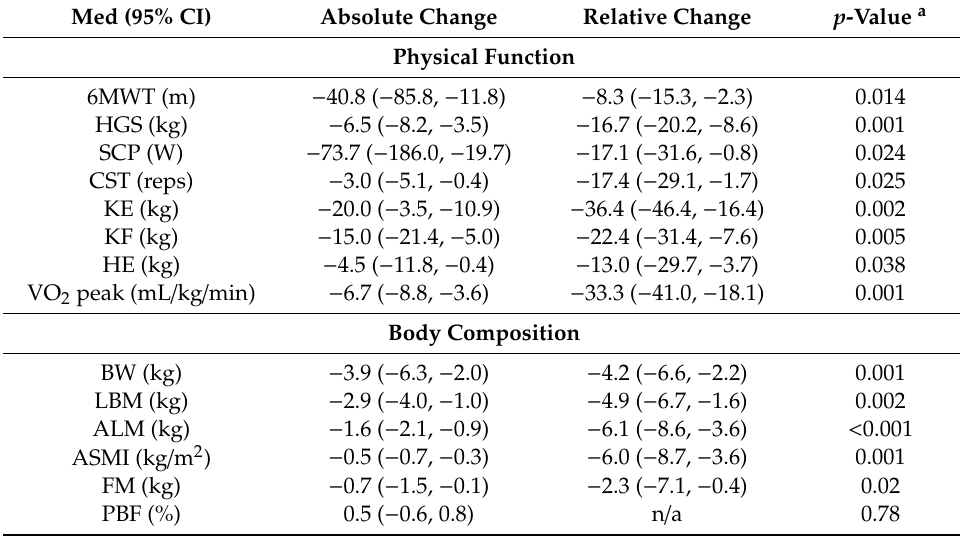
Table 2. Changes in physical function, body composition, energy expenditure, and